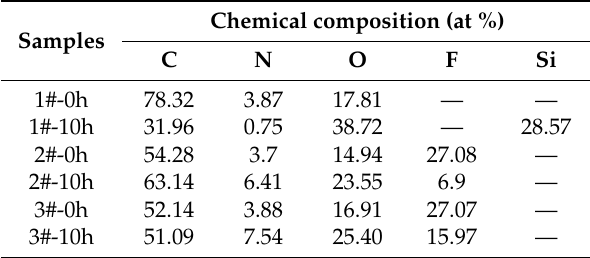
Table 1. Relative chemical composition as determined by XPS before and after plasma processing. Samples